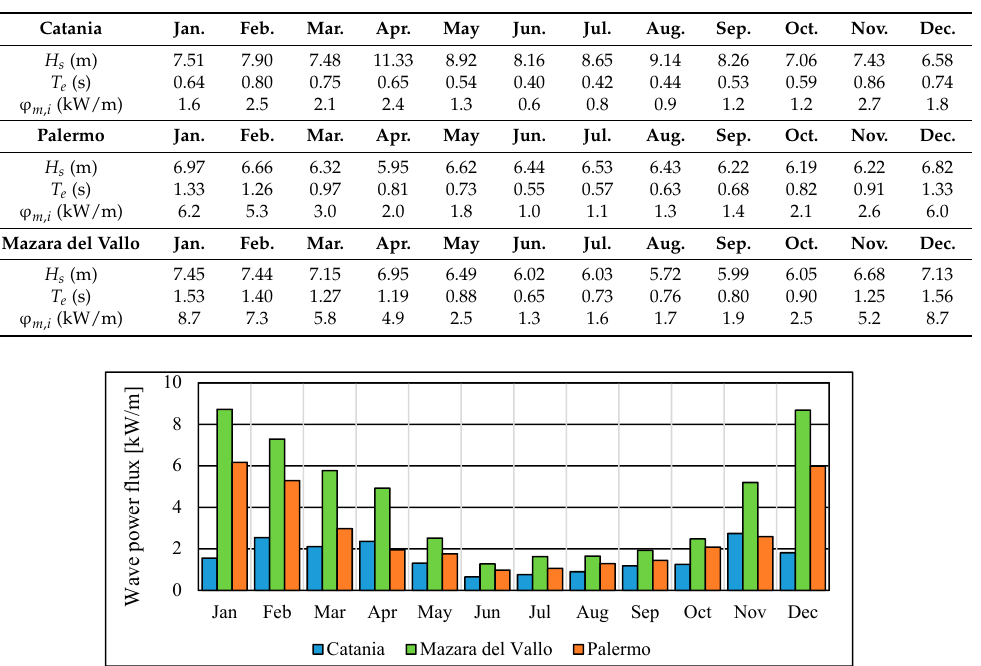
Table 2. Monthly average wave data in Catania, Palermo, and Mazara del Vallo (2002–2011). Catania